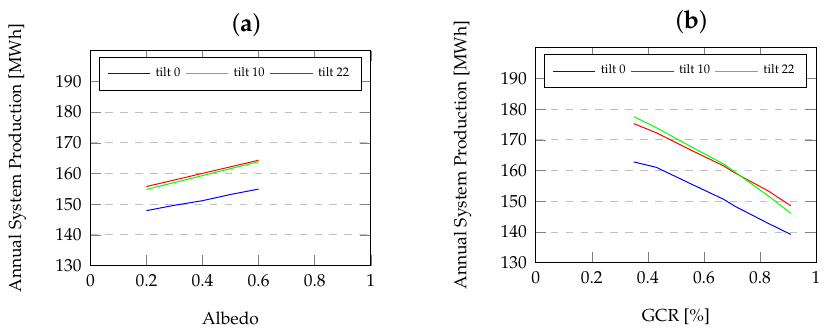
Figure 10. Tilt angle variation with ( a ) albedo and ( b ) GCR at the location